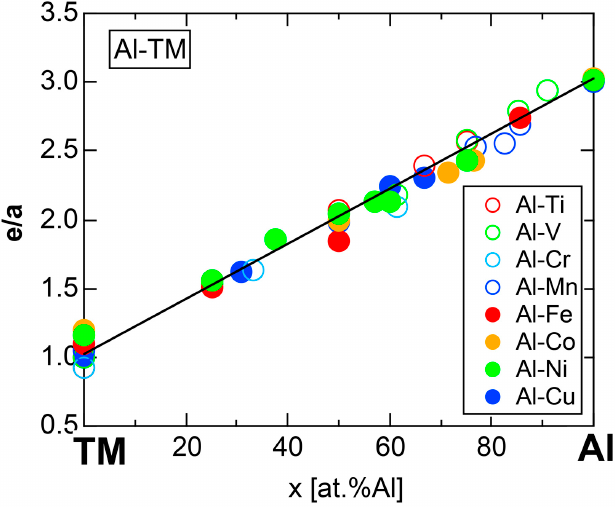
Figure 54. Composition dependence of e/a for compounds in TM-Al (TM = Ti to Cu) alloy system. The